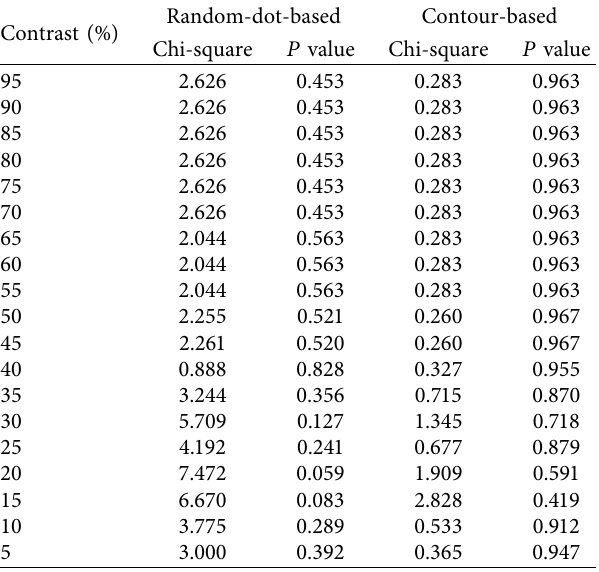
Figure 4: The flowchart of test procedure. Test groups included 4 random-dot-based patterns (maximum brightness 240 lux, 120 lux, 60 lux, or 30 lux) and 4 contour-based patterns (maximum brightness 240 lux, 120 lux, 60 lux, or 30 lux). One group was selected randomly to test a participant. Two-step choices were conducted to measure the stereopsis threshold of 5% contrast, and then 10% contrast, and so on, until 95% contrast. Randomly, another group was chosen to do the examination again, and so on, until finishing all the 8 groups’ tests. Table 1: Kruskal–Wallis test result of the four groups with different screen